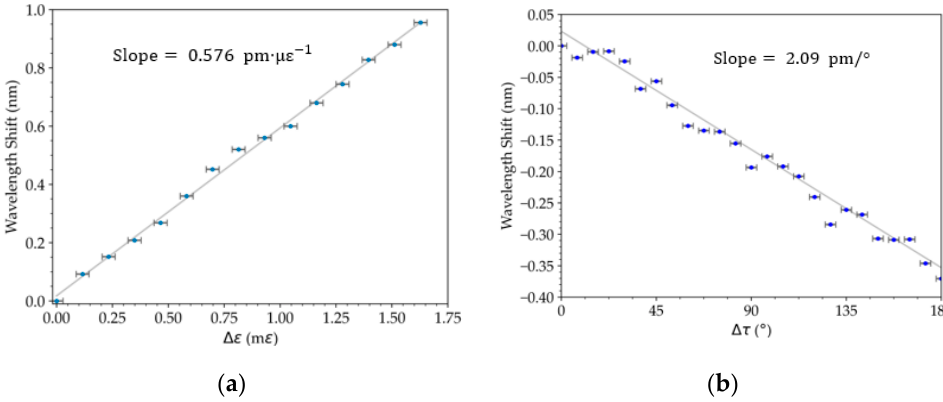
Figure 5. Response of the FLM in wavelength shift: ( a ) strain and ( b ) torsion.